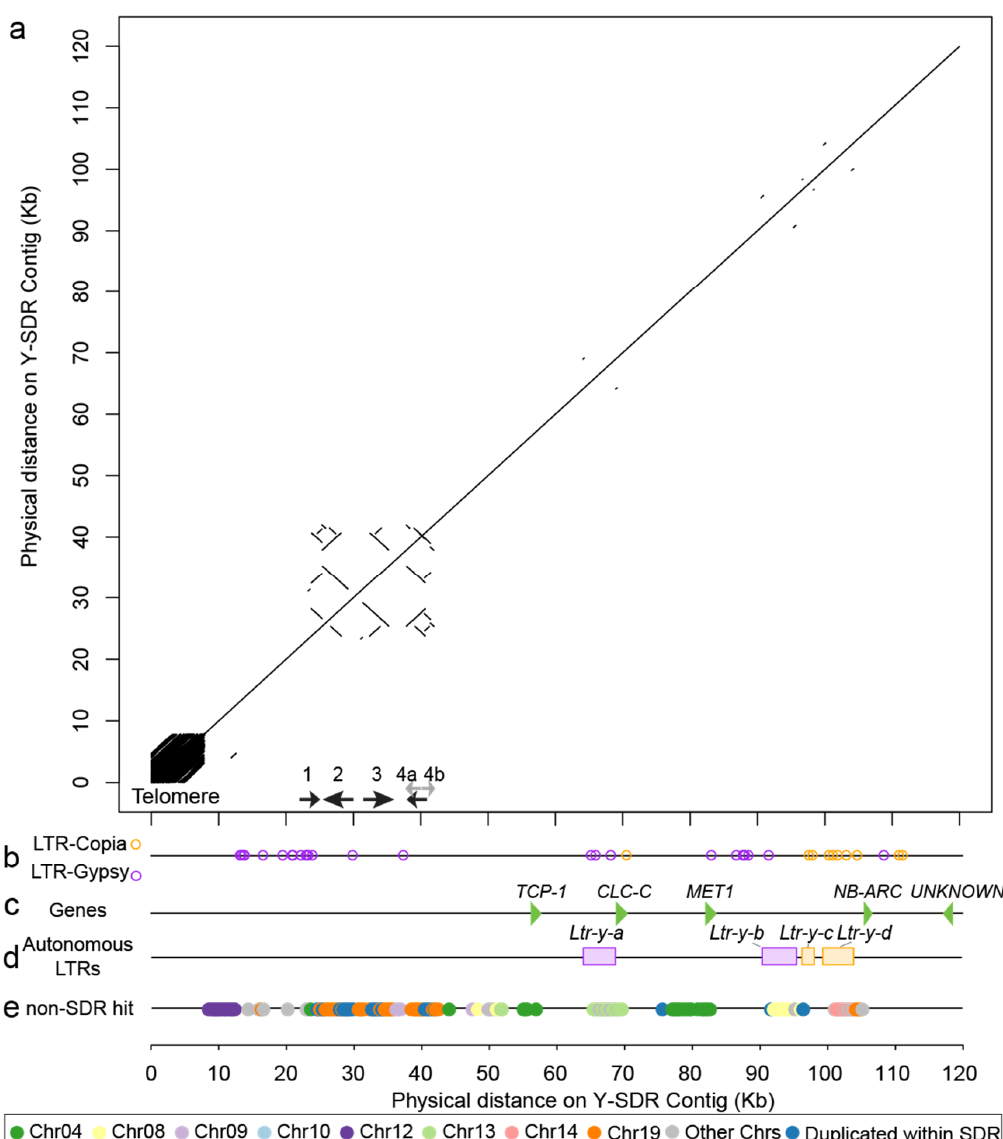
Figure 4. Dotplot and landscape of genomic contents of the Y-SDR in P. trichocarpa . ( a ) A dotplot of the alignment between the genomic sequence in the SDR in P. trichocarpa Stettler-14 to itself. ( b ) LTR-Copia and LTR-Gypsy elements identified from RepeatMasker were plotted as circles. ( c ) Five genes in the SDR are shown with green triangles. ( d ) Autonomous LTRs identified from LTRdigest / LTRharvest are shown with colored rectangles. Purple ones are from LTR-Gypsy superfamily and orange ones are from LTR-Copia superfamily. ( e ) Transposition identified in the SDR. Non-SDR hits of 200 bp sequence chunks from SDR. Only sequence chunks with single hit were kept. LTR: long terminal repeat.